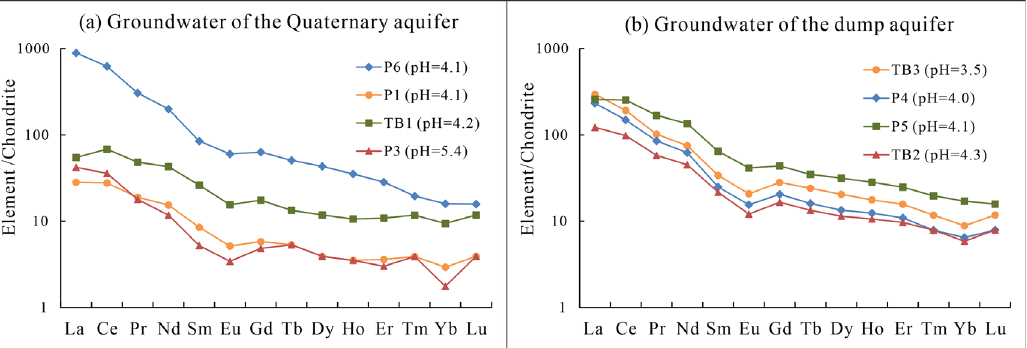
Figure 11. Chondrite - normalized patterns of dissolved REEs in an acidic mine lake (Lusatia lake, Germany) with pH values: ( a ) Groundwater of the Quaternary aquifer, ( b ) Groundwater of the dump aquifer (date referenced from [52]) .